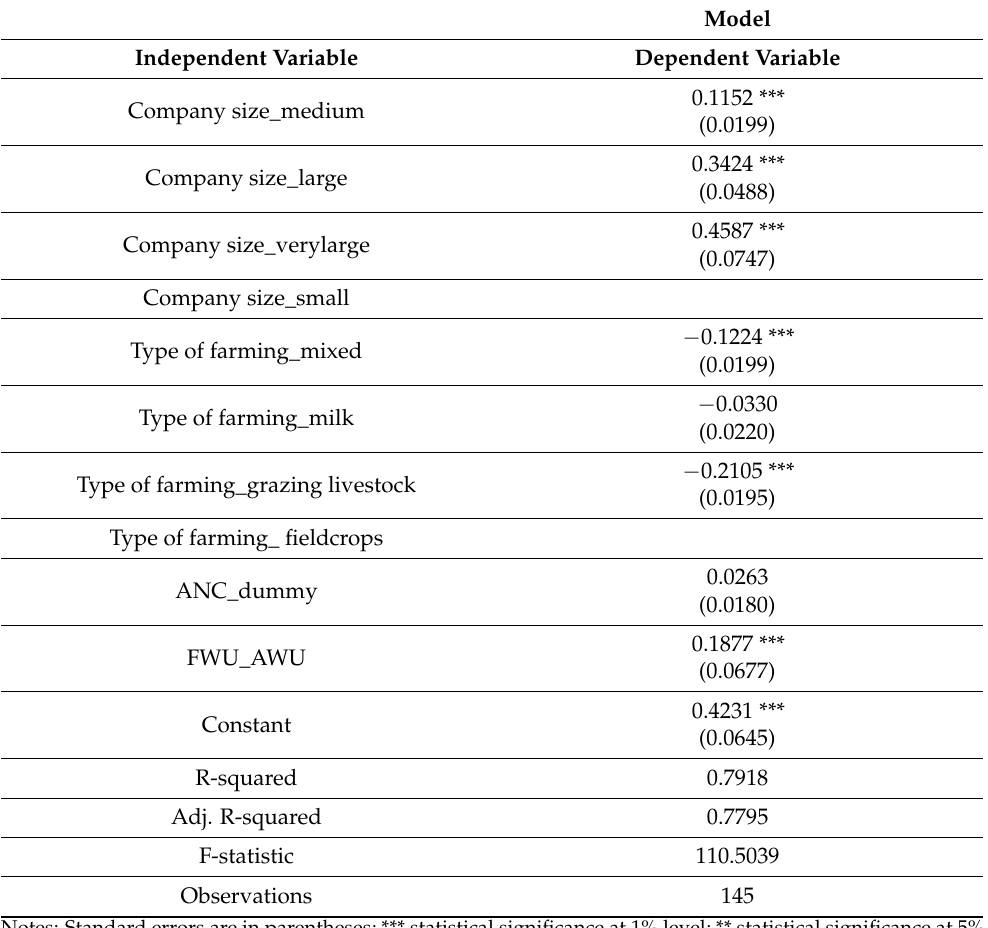
Table 9. Model table—the determinants of total factor